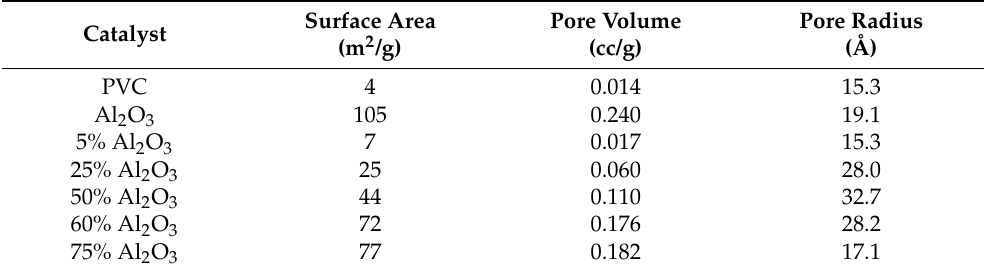
Table 1. Textural properties of the Al 2 O 3 /PVC catalysts. Specific surface area pore volume and pore